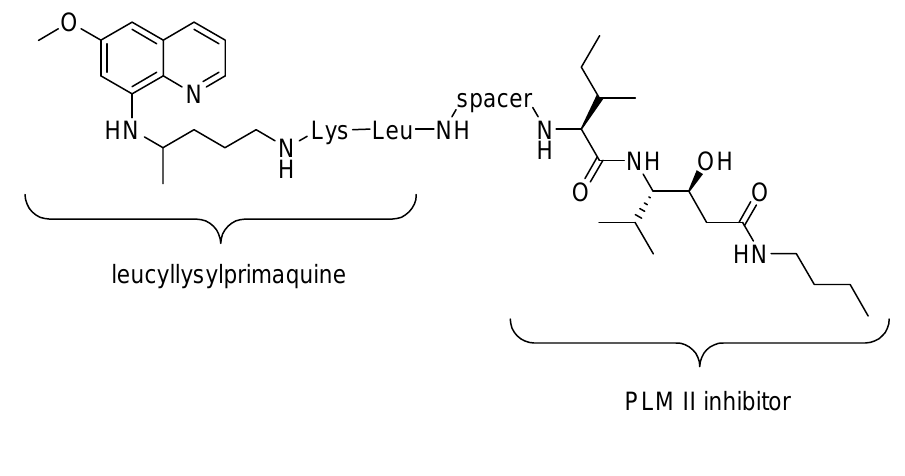
Figure 25. Primaquine-statine pro-prodrugs.